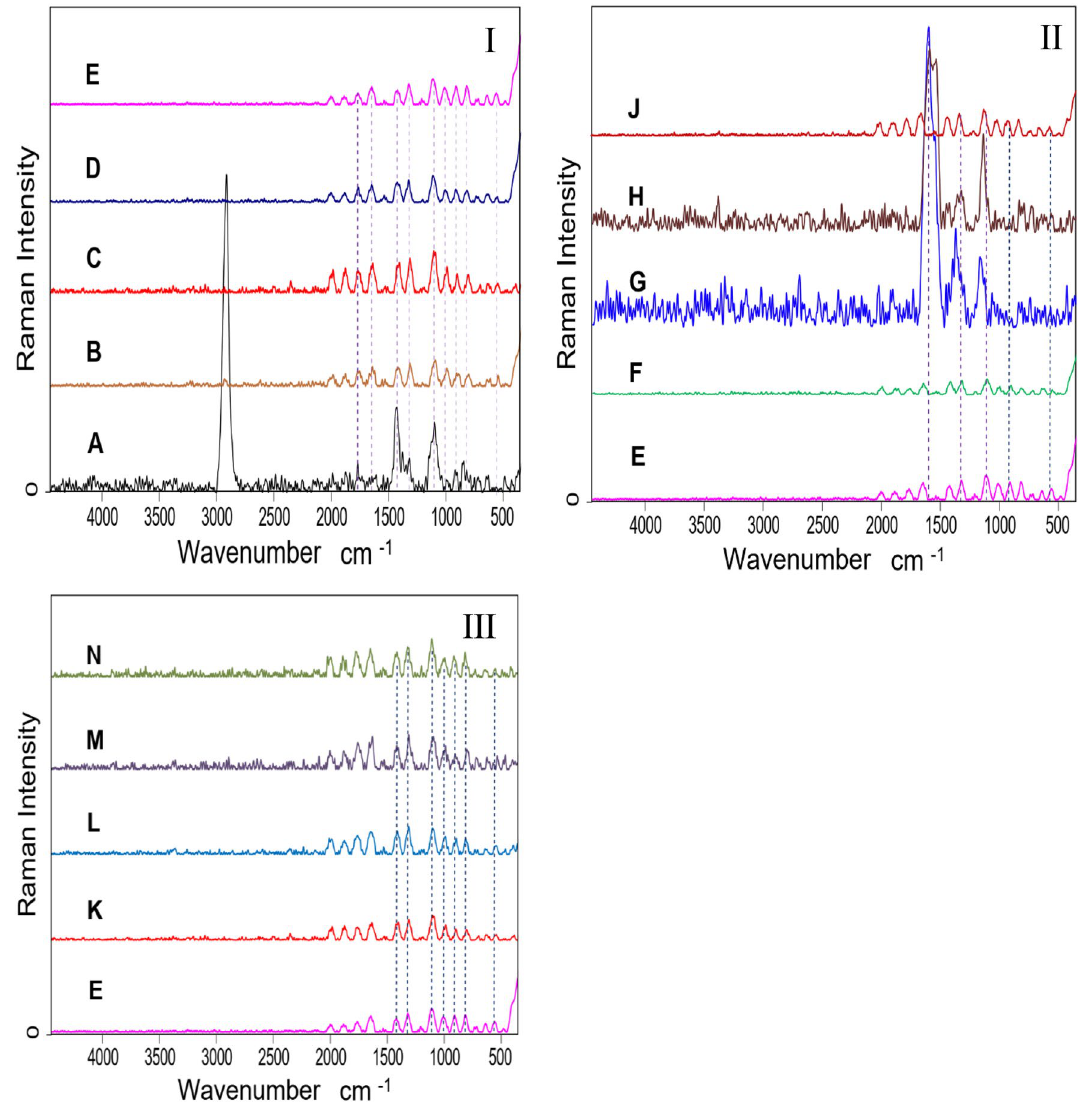
Figure 2. ( I ) Raman spectra of ( A ) CMC/PVA/AA, ( B ) CMC/PVA/AA-(1%) CSA, ( C ) CMC/PVA/AA-(2%) CSA, ( D ) CMC/PVA/AA-(3%) CSA, ( E ) CMC/PVA/AA-(4%) CSA. ( II ) Raman spectra of ( E ) CMC/PVA/ AA-(4%) CSA, ( F ) CMC/PVA/AA-(4%) CSA-(0.5%) CCNT. ( G ) CMC/PVA/AA-(4%) CSA-(1%) CCNT. ( H ) CMC/PVA/AA-(4%) CSA-(1.5%) CCNT. ( J ) CMC/PVA/AA-(4%) CSA-(2%) CCNT. ( III ) Raman spectra of ( E ) CMC/PVA/AA-(4%) CSA. ( K ) CMC/PVA/AA-(4%) CSA-(0.5%) SAC. ( L ) CMC/PVA/AA-(4%) CSA-(1%) SAC. ( M ) CMC/PVA/AA-(4%) CSA-(1.5%) SAC. ( N ) CMC/PVA/AA-(4%) CSA-(2%)